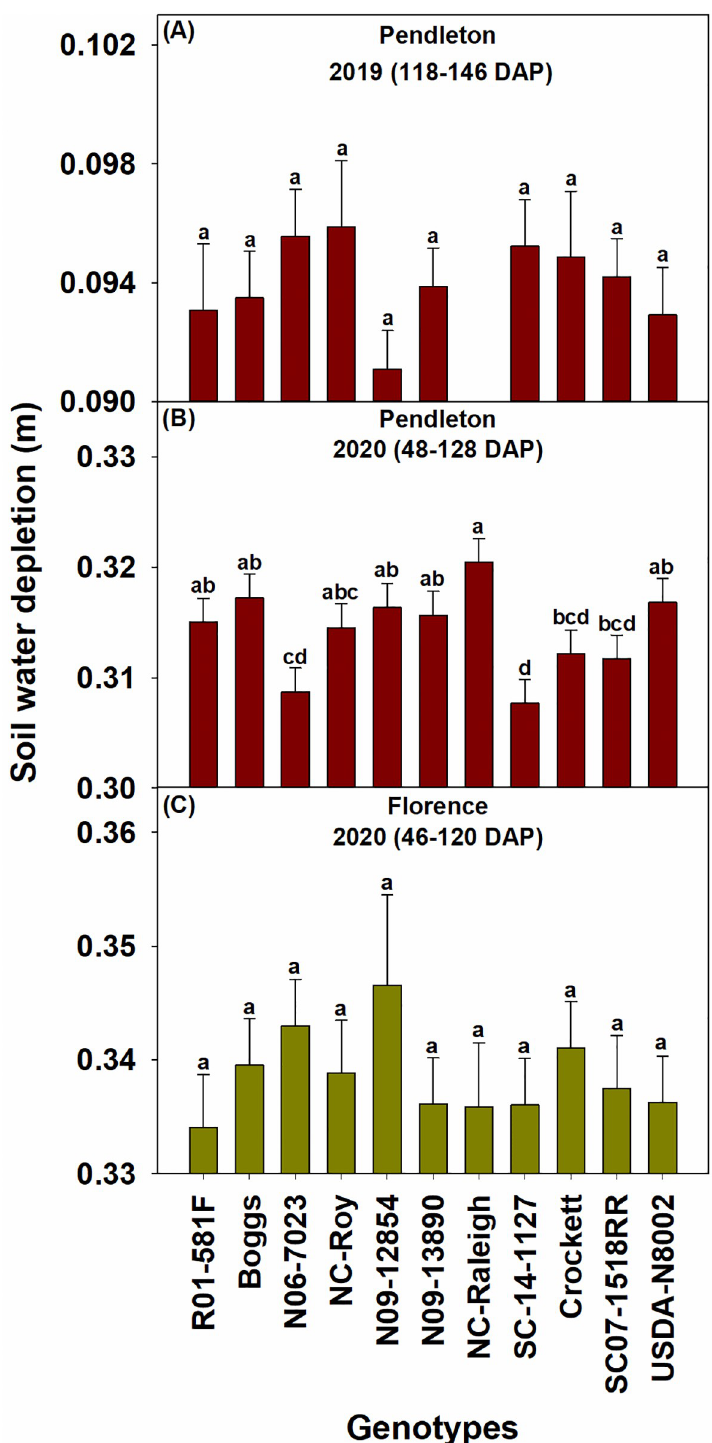
Fig 5. Soil water depletion by the soybean genotypes at Pendleton (2019, Panel A and 2020, Panel B) and Florence (2020, Panel C) in South Carolina. Soil water depletion was not measured at Florence in 2019. The missing data point at Pendleton in 2019 (NC-Raleigh) was due to rain damage to the access tubes installed in the plots for soil moisture measurement. Least squares means with different letters are significantly different according to the Fisher’s least significant difference (LSD) test at α < 0.05. DAP–days after planting. Most genotypes reached R5 or R6 growth